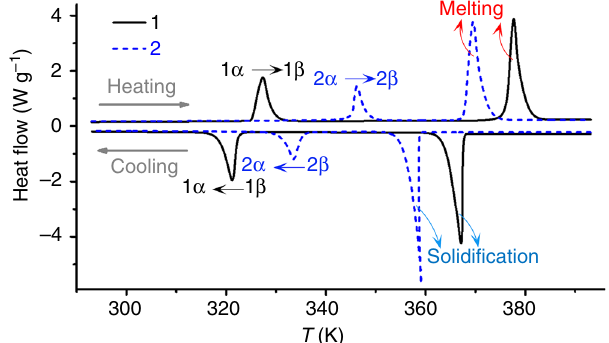
Fig. 3 Differential scanning calorimetry of coordination polymers. DSC measurements for CPs 1 and 2 recorded on a heating − cooling cycle.